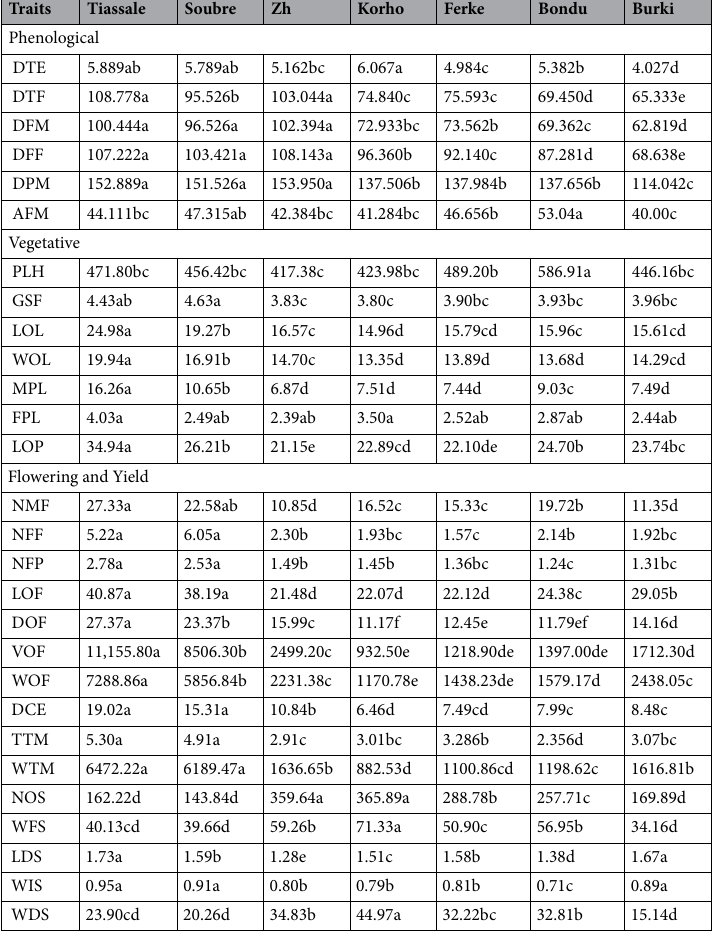
Table 1. Means of the measured phonological, vegetative and flowering and yield traits of Cucurbita moschata genotypes sampled from seven habitats. Read horizontally to compare the means of the accessions from different habitats. Means followed by the same letter are not significantly different ( α = 0.05 ). Read vertically to assess the accessions of a habitat over all the measured